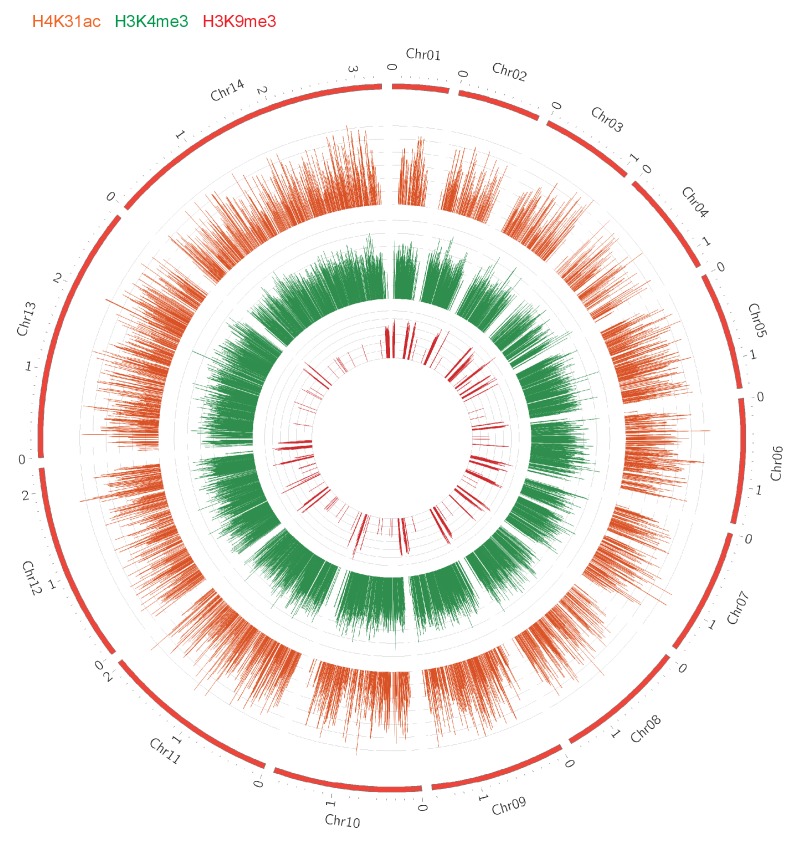
Chromosomal projection of H4K31ac, H3K9me3 and H3K4me3 occupancies in P. falciparum.The full set of chromosomes is represented in this circular plot.